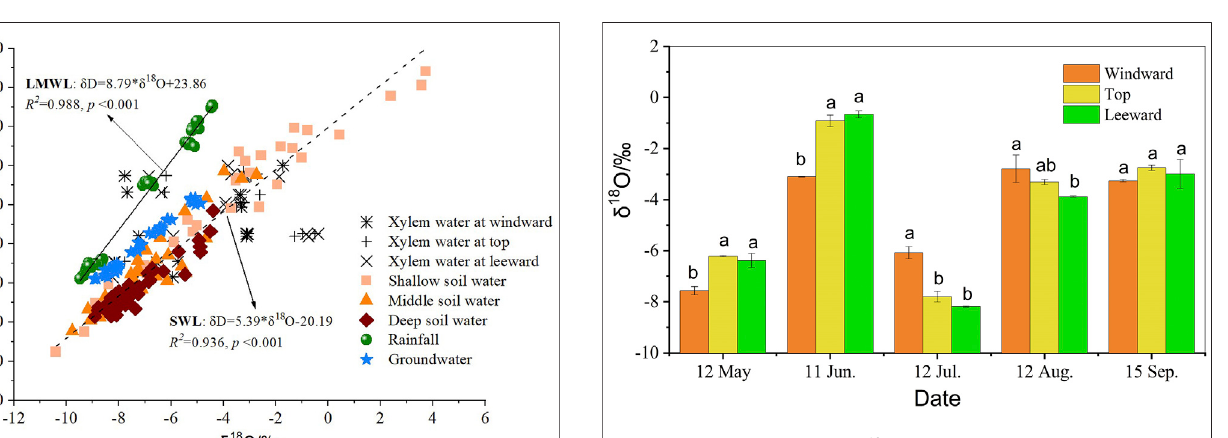
FIGURE8| Seasonalvariationin δ 18 Oxylemwaterof Artemisiaordosica (Ao) in positions with different dune geomorphology. The same letter means that there is no signi fi cant difference between different positions of dune ( p > 0.05), whereas different letters refer to signi fi cant differences between micro-landforms in dune ( p < 0.05).